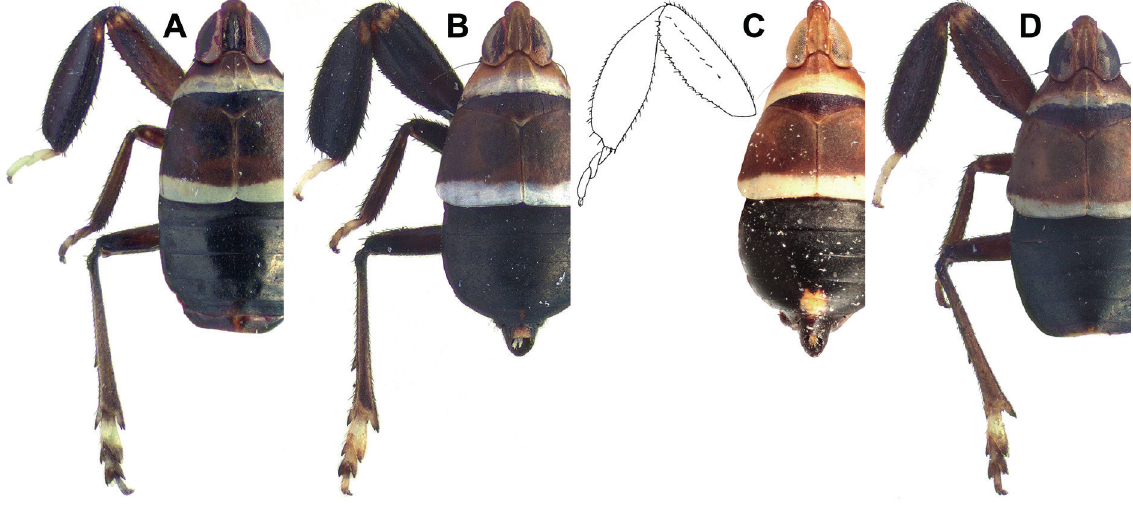
Fig. 1. Cleotyche ( Cleotyche ) Emeljanov, 1997 spp. of eastern Australia, ♂♂, dorsal view. A . C. ( Cleotyche ) christinae sp. nov. B . C. ( Cleotyche ) francescoi sp. nov. C . C. ( Cleotyche )